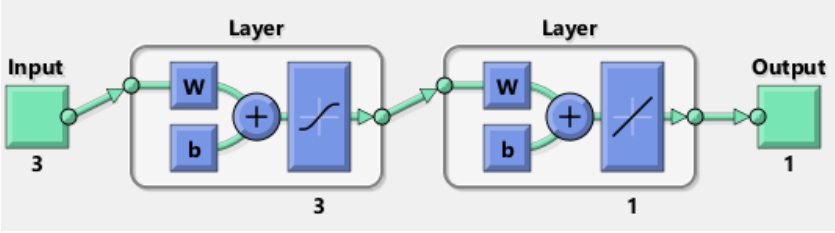
Figure 3. The topology of MLP-ANN for estimating H 2 solubility in biochemicals.